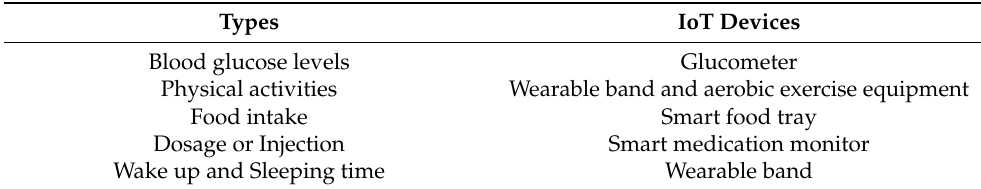
Table 1. Self-care IoT pack to obtain detailed lifestyle information for diabetic Mellitus.